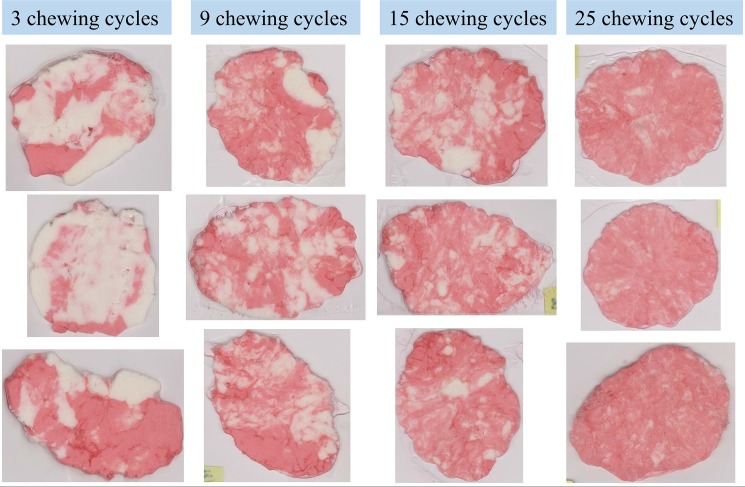
Example set of masticated chewing gums.